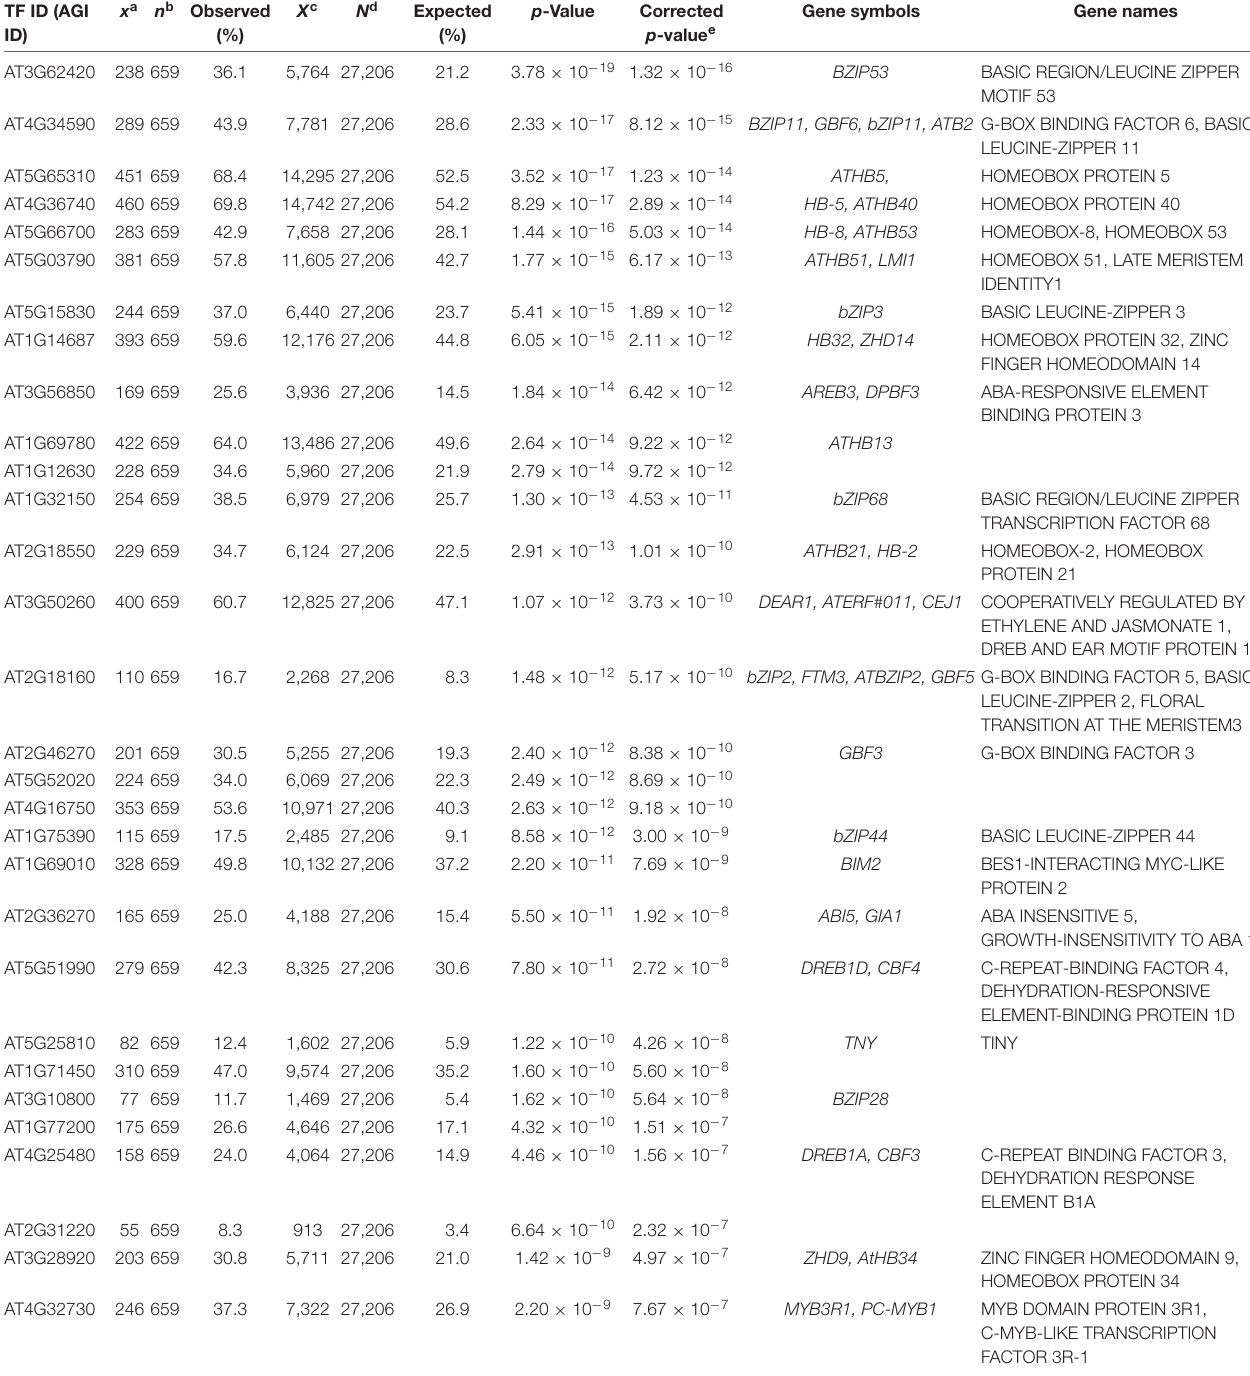
TABLE 4 | Summary statistics of enriched upstream TFs for down-regulated genes in Arabidopsis roots upon 1 µ M IAA treatment for 6 h (Omelyanchuk et al., 2017). TF ID (AGI